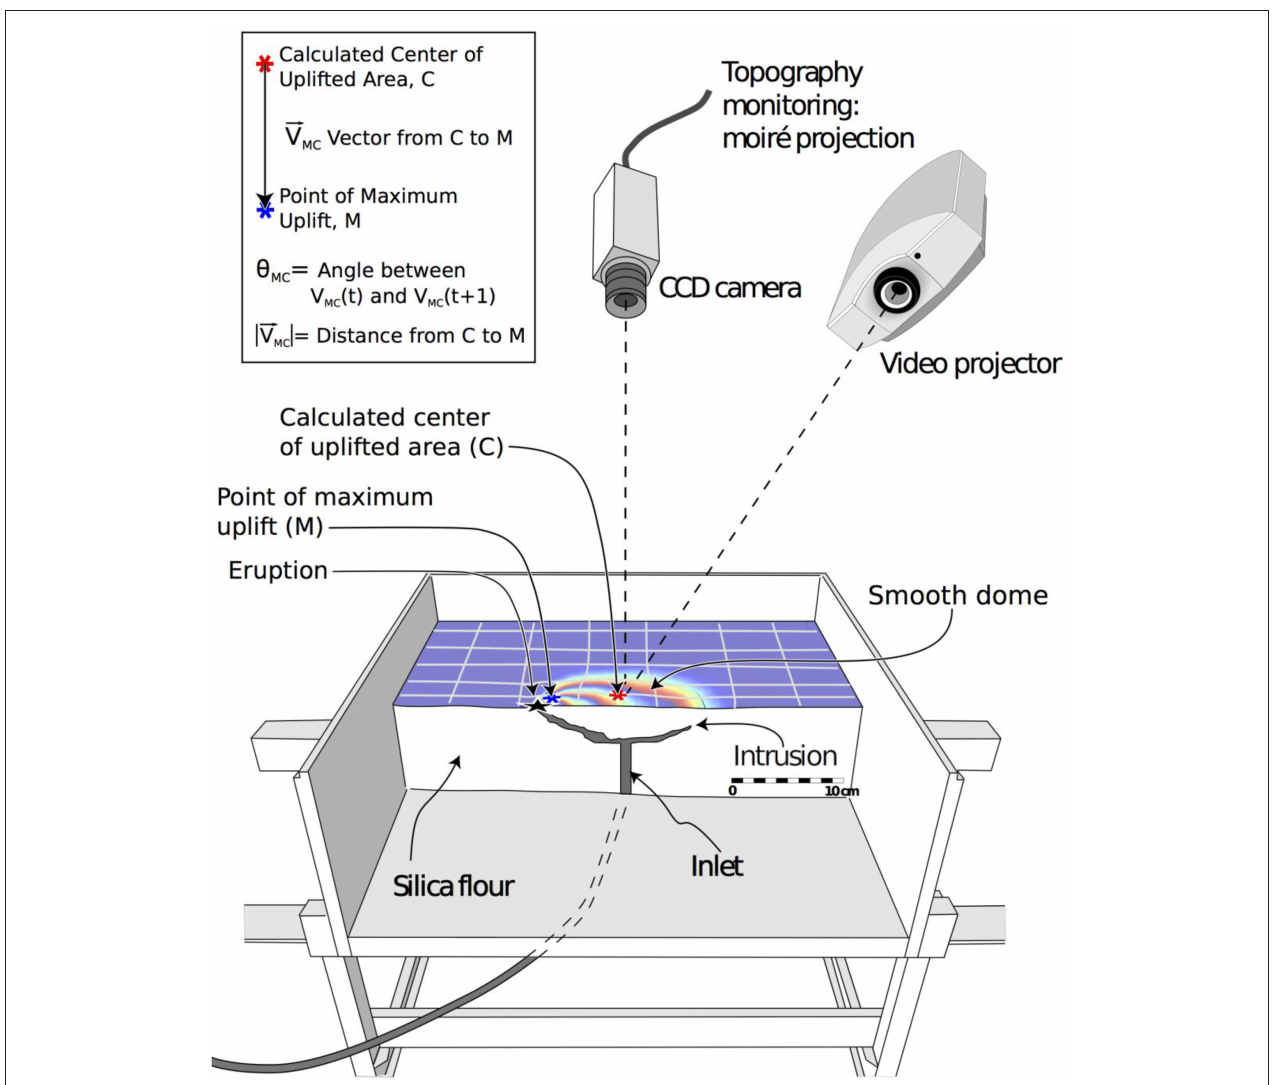
FIGURE 1 | Experimental device used to simulate shallow intrusions of oil into silica flour (adapted from (Galland, 2012) with permission, Galland et al., 2006, 2014), which induced uplift of the surface of the models that were periodically monitored (1.5s time steps) using a moiré projection system (Bréque et al., 2004; Galland, 2012), and fed eruptions (black star). At each time step of a given experiment, simple geometrical parameters (see legend box) were calculated from the surface uplift map. This study shows that their evolution with time represents a precursor for the location of the next